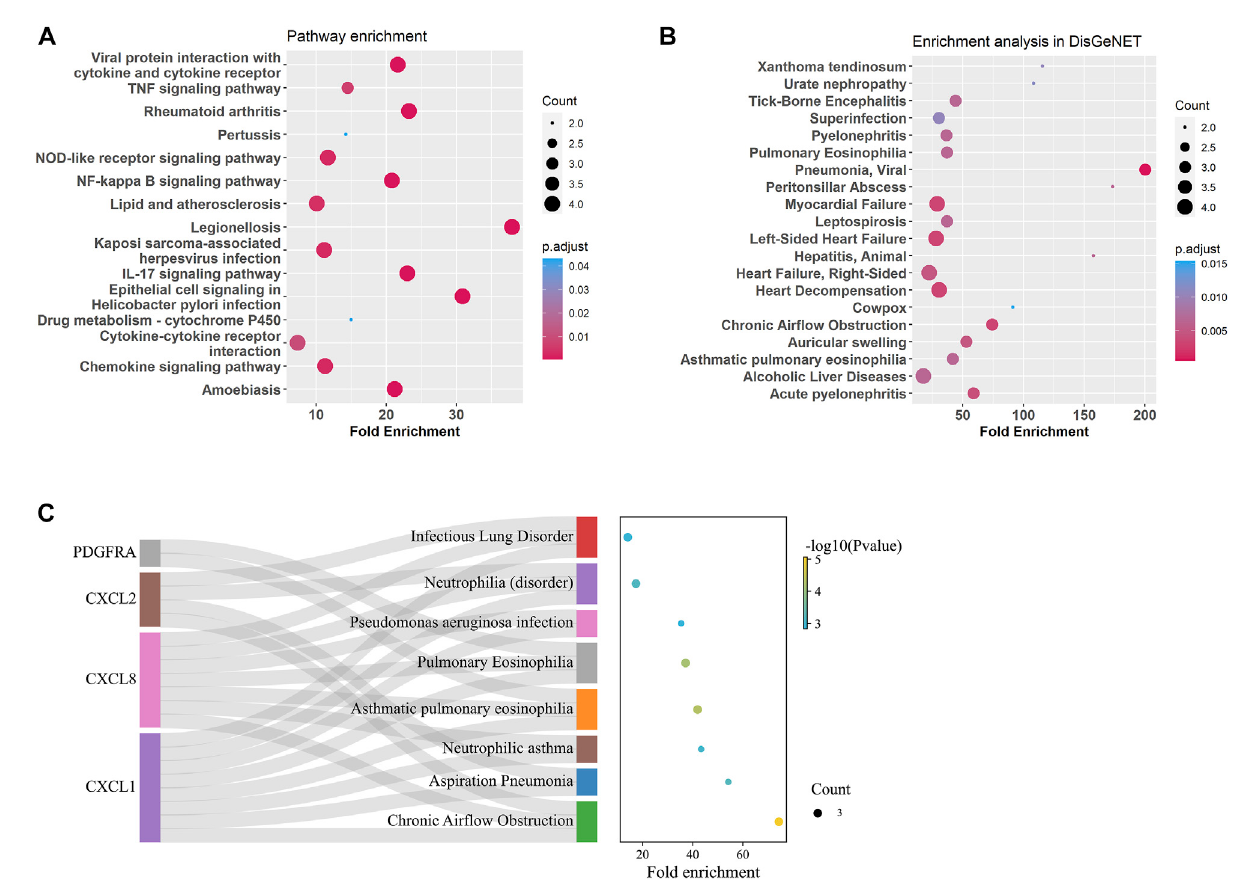
FIGURE 5 Enrichment analysis for age-related DEGs in the trachea. (A) Summary of KEGG enrichment in the trachea. (B) Summary of DisGeNET enrichment in the trachea. (C) Sankey plot showed relation between age related-DEGs and signi fi cant enriched ( p adjust < 0.5) pulmonary diseases.